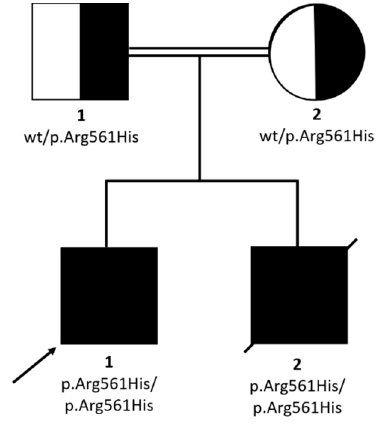
Figure 3. Pedigree and family segregation of SMARCAL1 variant (c.1682G>A; p.Arg561His).